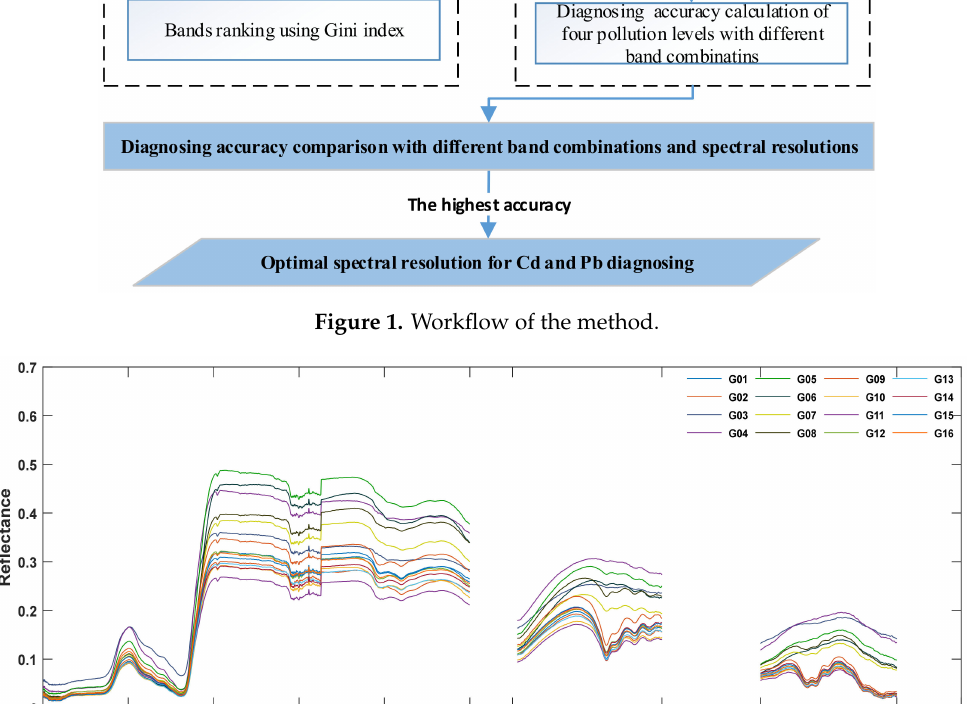
Figure 2. Raw reflectance after removing part of bands for first time